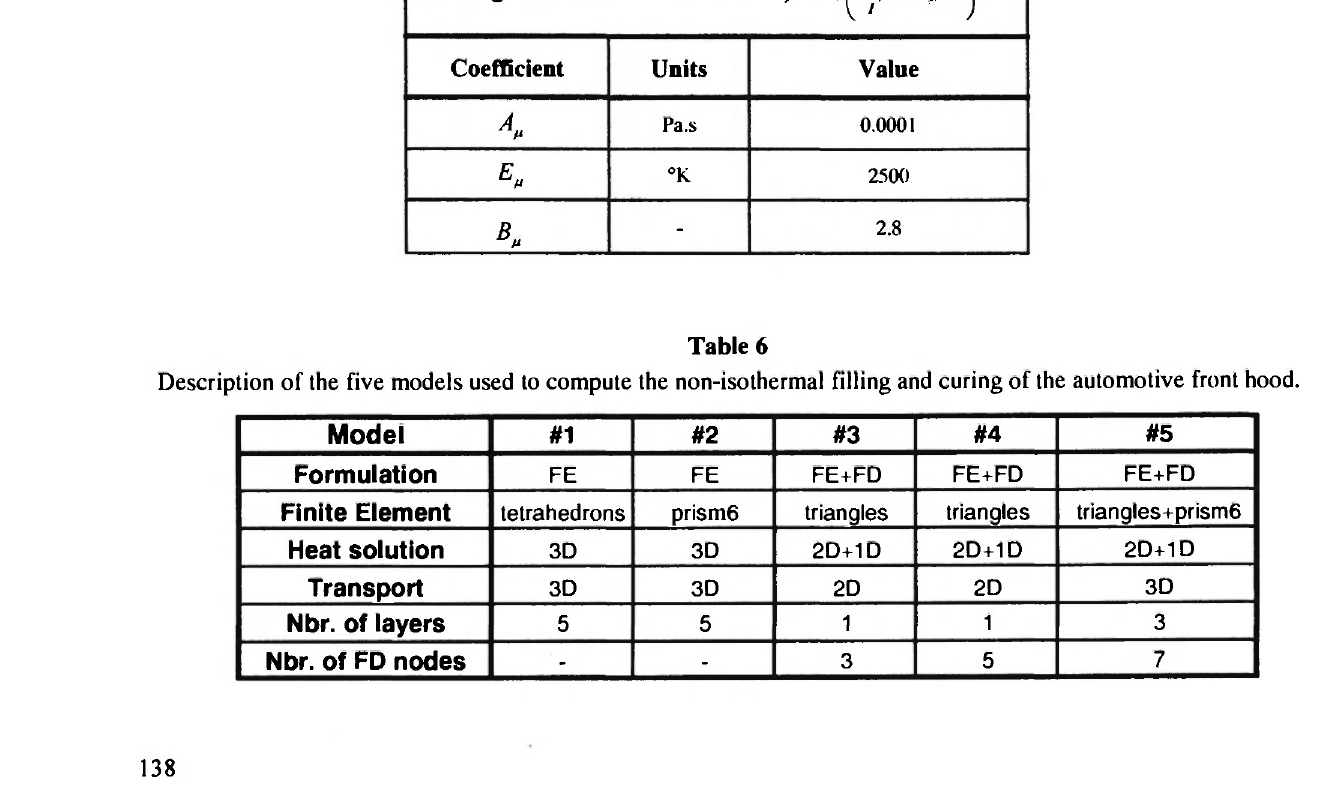
Rheological model used in the non-isothermal simulation of the automotive front hood.